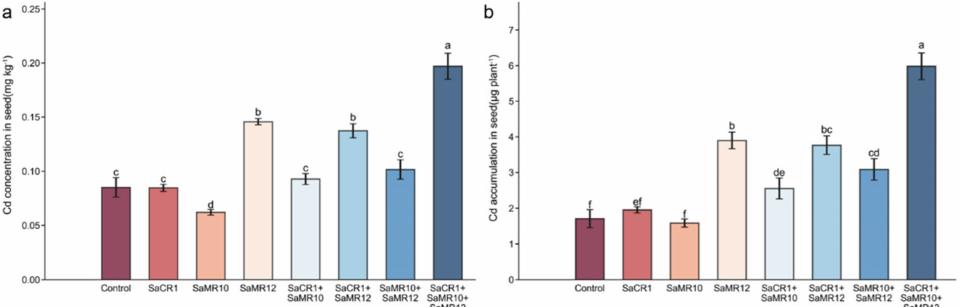
Figure 4. Effects of PGPB inoculants on the seed ( a ) Cd concentration and ( b ) Cd accumulation. The letters above the column indicate the significant differences among different treatments at p < 0.05.